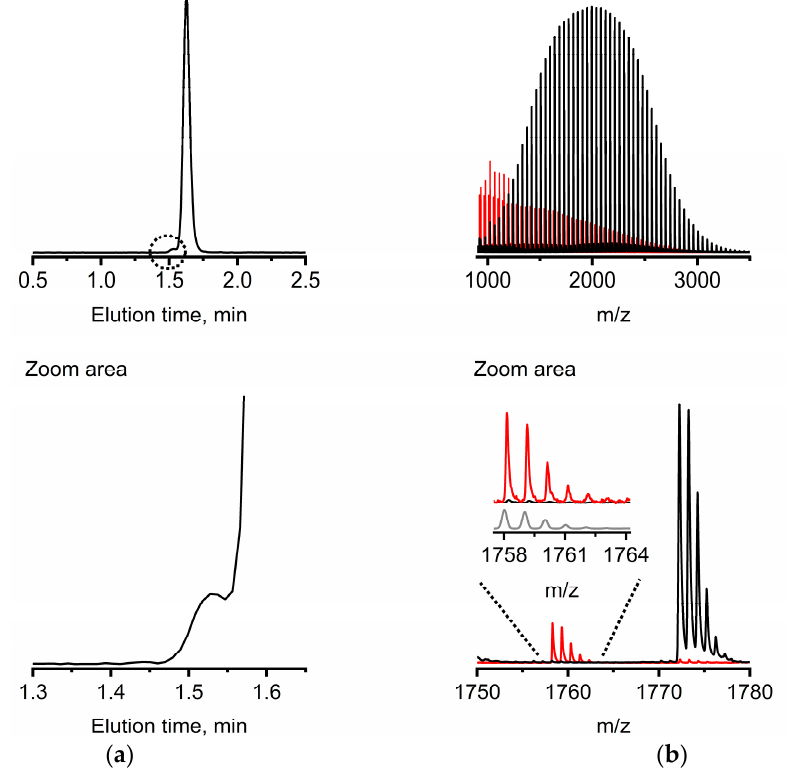
Figure 4. Application example of the developed methodology under the same chromatographic conditions as in Figure 3. ( a ) Elution trace of the 1 mg mL − 1 anionic ring opening polymerization product containing potential diol impurity and ( b ) MALDI-TOF-MS of the collected small elution fraction identified as PEGdiol (shown in red) and major elution fraction identified as mPEG (shown in black). The inset in the right panel of ( b ) also contains the theoretical isotopic fragmentation pattern of PEGdiol shown in gray.